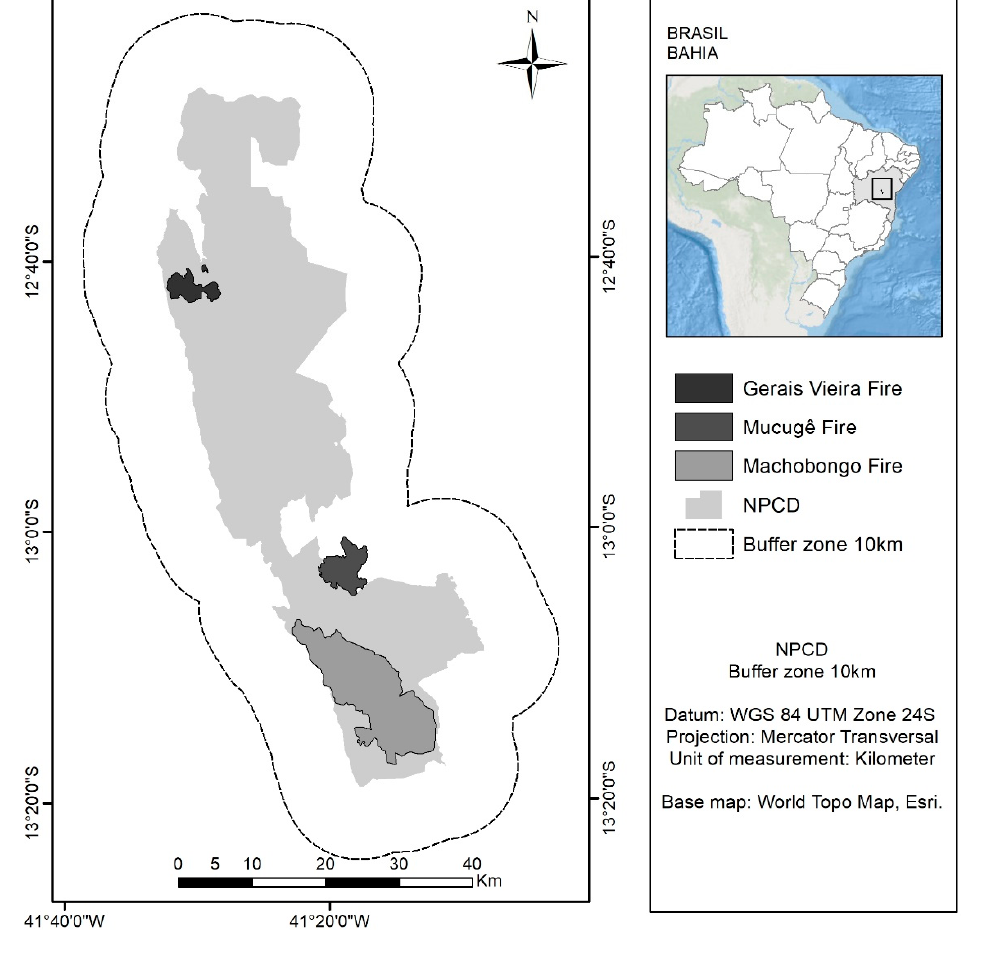
Figure 1. Location of the study areas. The Chapada Diamantina National Park (PNCD) is represented in light gray. The dashed line corresponds to the 10-kilometre buffer (surrounding area). The study areas correspond to polygons with black outlines (the scars of the fires identified from the application of the normalized burn ratio (NBR) spectral index).